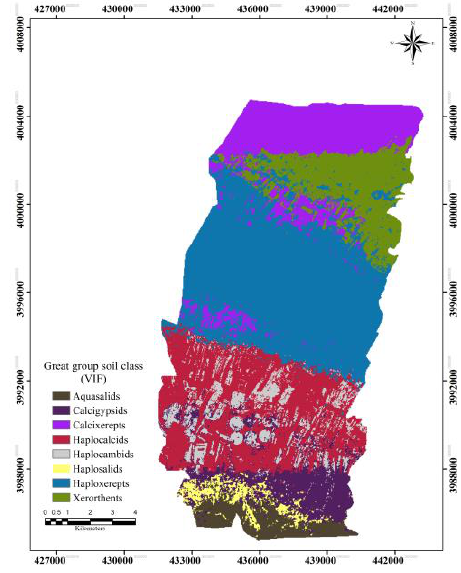
Figure 2. Spatial distribution of the soil great groups derived from RF model